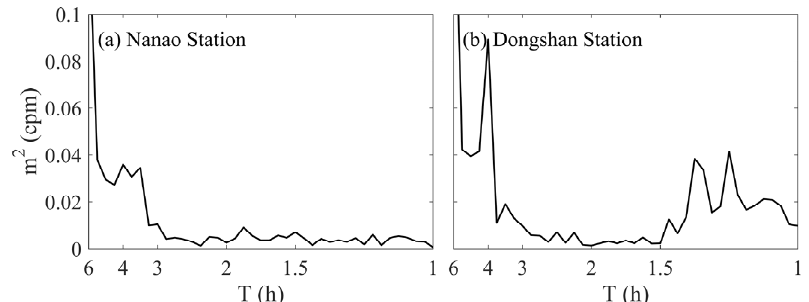
Figure 3. Power spectra of observed 10-min sea levels with tidal components removed at ( a ) Nanao and ( b ) Dongshan stations after the passage of Typhoon Mawar in September 2017.